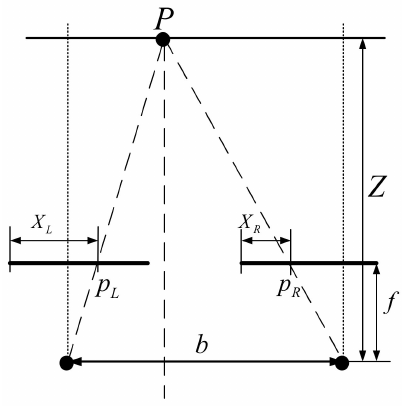
Figure 3. Canonical stereo